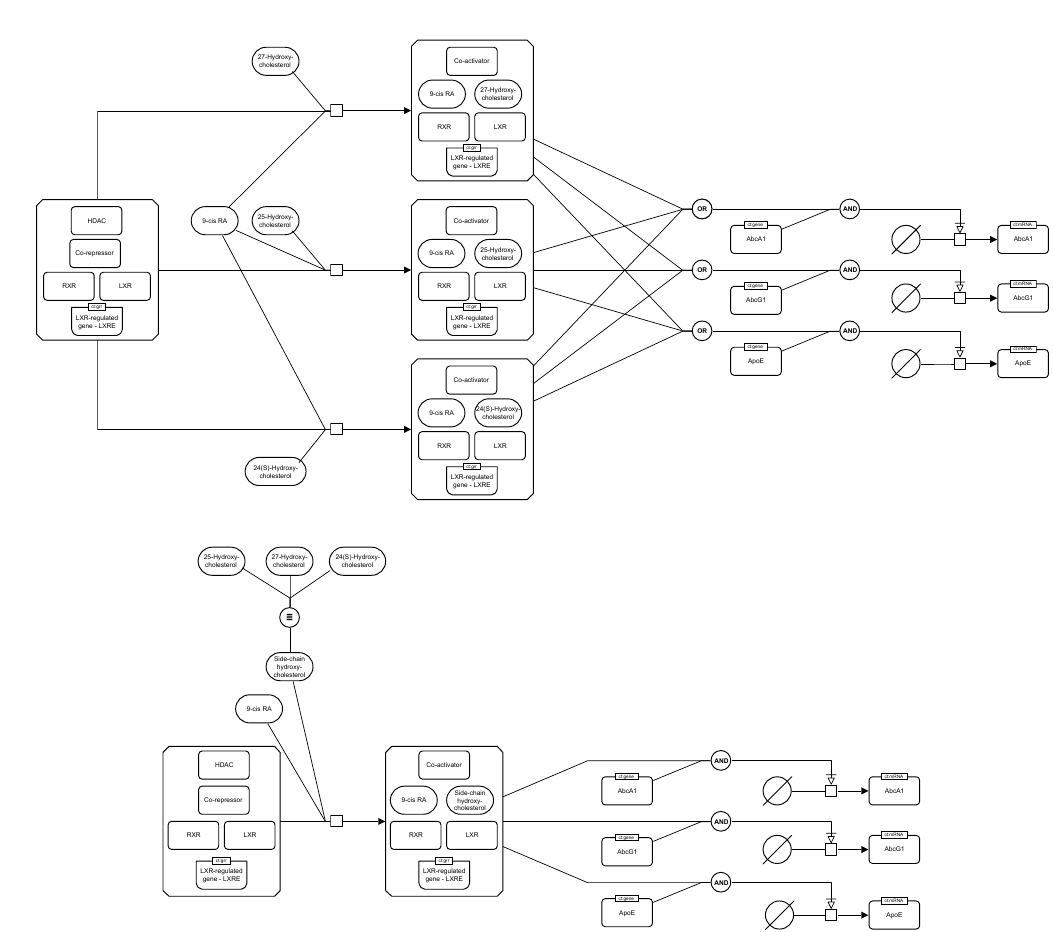
Figure B.1: LXR signalling induced by 25-hydroxycholesterol, 27-hydroxycholesterol and 24(S)-hydroxycholesterol. A. Without an equivalence operator : events have to be multiplied for the three hydroxysterols. B. With an equivalence operator : a compact representation is possible allowing a better